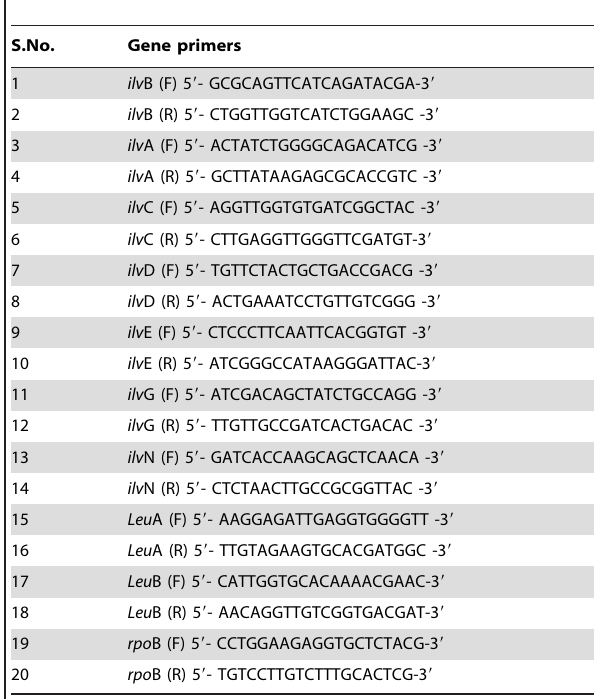
Table 4. Primers used for transcriptome